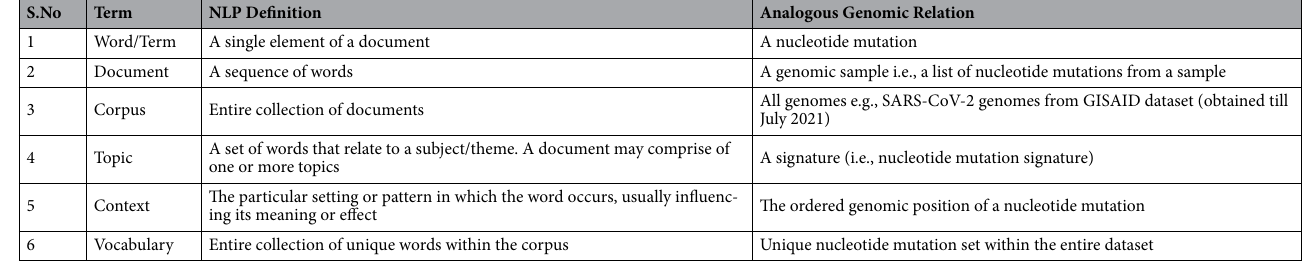
Table 1. Analogy between NLP terms used for documents and genomes.